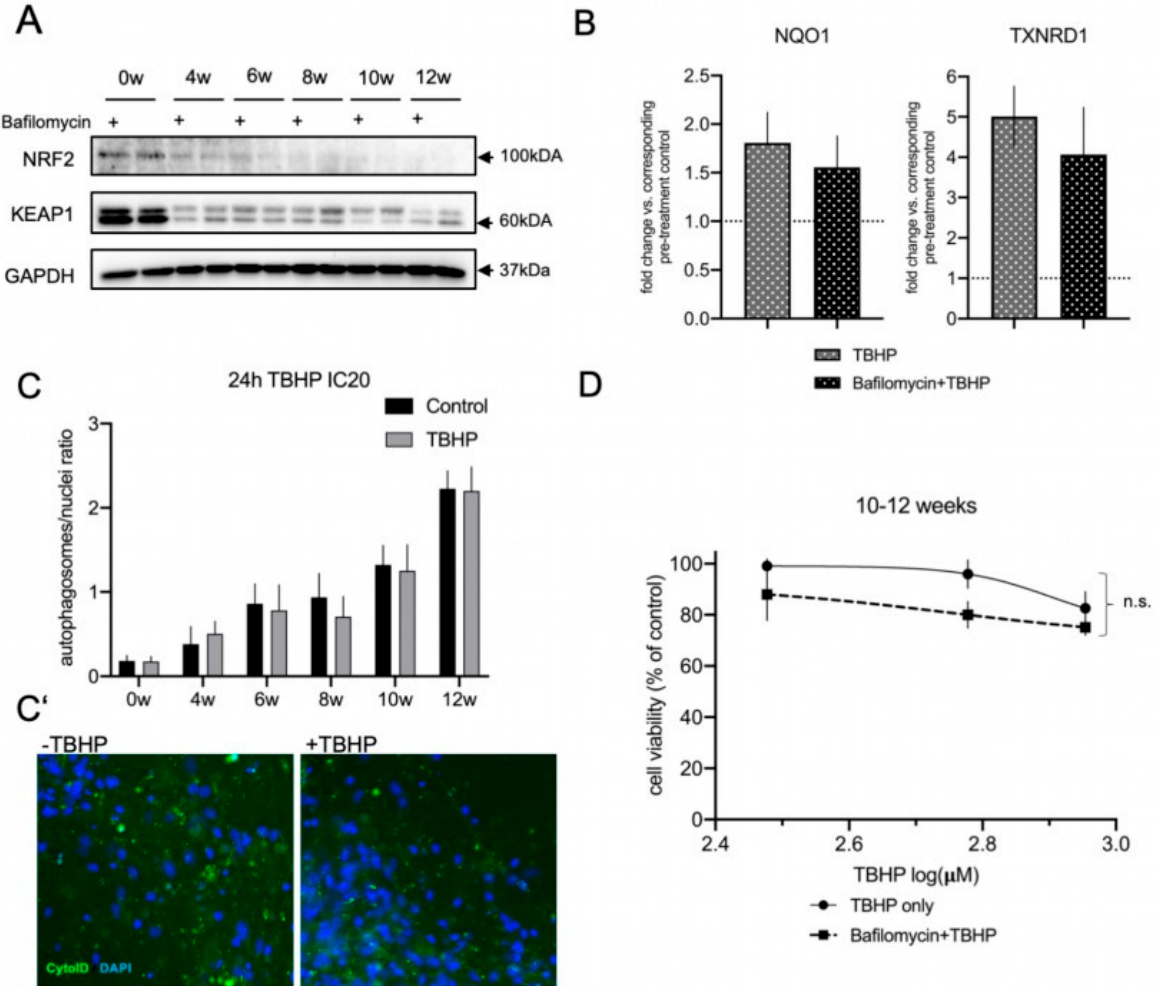
Figure 5. Autophagic flux does not contribute to the acute oxidative stress response in differentiating lt-NES cells. ( A , B ) Crosstalk between autophagy and KEAP1-NRF2 pathway regulation. ( A ) Western blot analysis of NRF2 and KEAP1 protein levels across lt-NES differentiation upon autophagic flux inhibition (by Bafilomycin) for 17 h. ( B ) NRF2 pathway downstream target gene expression under OS induction upon autophagic flux inhibition. lt-NES